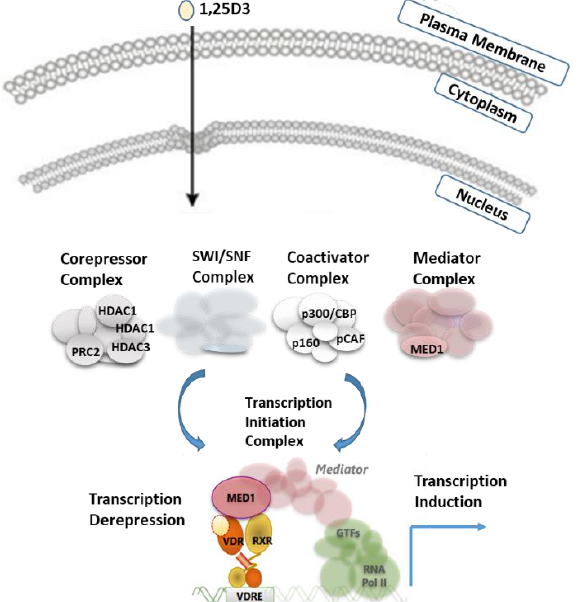
Figure 1. Schematic model for VDR regulation. Upon 1,25D 3 binding to VDR, VDR translocates into the nucleus, binds as a heterodimer with RXR to DNA and interacts with various coregulators, leading to the activation of transcription or relief of constitutive repression.